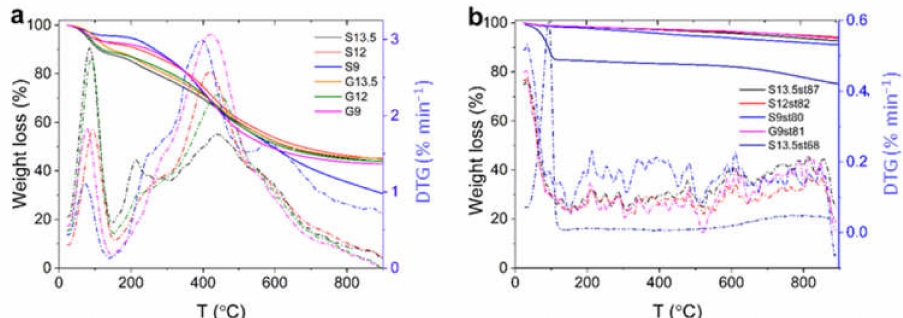
Figure 5. TG and DTG curves of acid-chars ( a ) and derived activated carbons ( b ) in N 2 atmosphere. In the case of the acid-chars, and in line with previous data for sisal-derived acid- chars [21], TG curves show two major weight loss steps with corresponding thermal events in the DTG curves (Figure 5a). Up to 150 ◦ C samples lost between 5 and 12% of weight due to the release of physically adsorbed water, pointing out some hydrophilicity of the materials. This is not surprising since pH PZC values of the acid-chars are between 2 and 3 (Table 1). The second mass loss (from 150 ◦ C up to 900 ◦ C) can be assigned